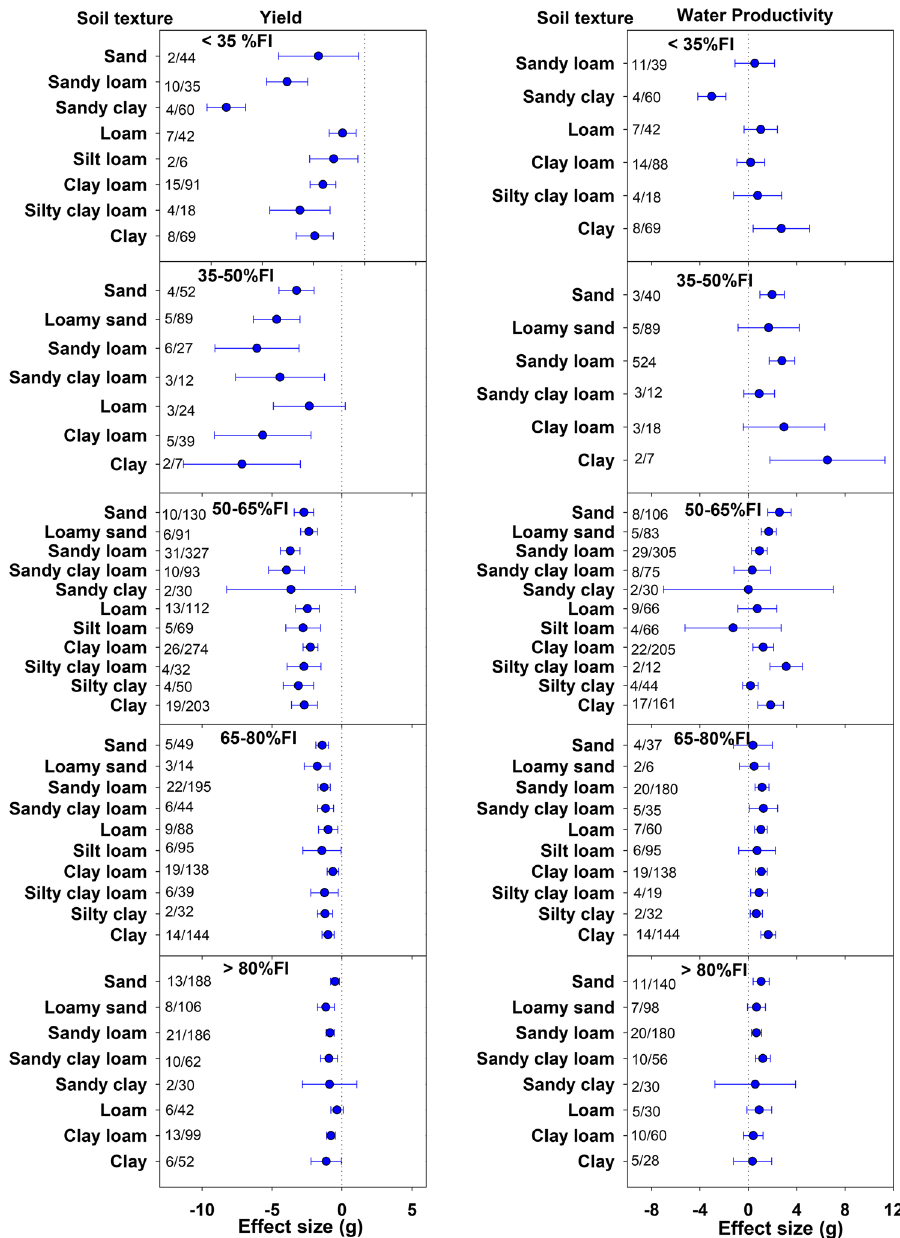
Figure 3. Effect of deficit irrigation levels on yield and water productivity (WP) across different soil textures. The dotted line (effect size = 0) represents full irrigation. Effect size > 0 indicates increase and effect size < 0 indicates reduction in yield and WP for deficit irrigation level relative to full irrigation (FI). Non-overlapping confidence intervals (horizontal bars) indicate significant differences. Numbers on right side of Y-axis represent number of